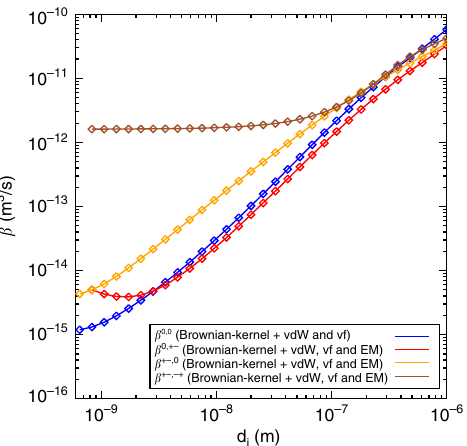
Fig. 4 Comparison of experiments and theory. Time difference between γ -on pro fi le and γ -off pro fi le averaged between d = 6 nm and d = 12 nm as a function of sulfuric acid concentration. The red circle symbols are for Δ q = 196 ion pairs cm − 3 s − 1 and blue circles are for Δ q = 55 ion pairs cm − 3 s − 1 . Error bars are the 1 std. dev. uncertainty. The red (blue) curve is the theoretical expectation based on Eqs. (7) and (8). Right-hand axis is the relative change in growth rate averaged between d = 6 nm and d = 12 nm, in %